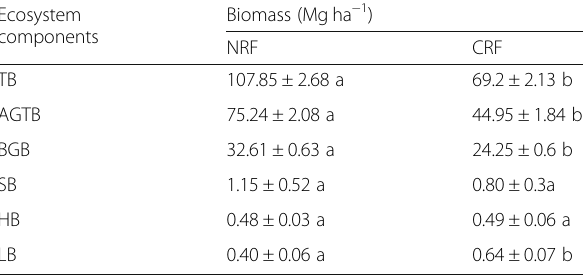
Table 3 Biomass in different ecosystem components Ecosystem components